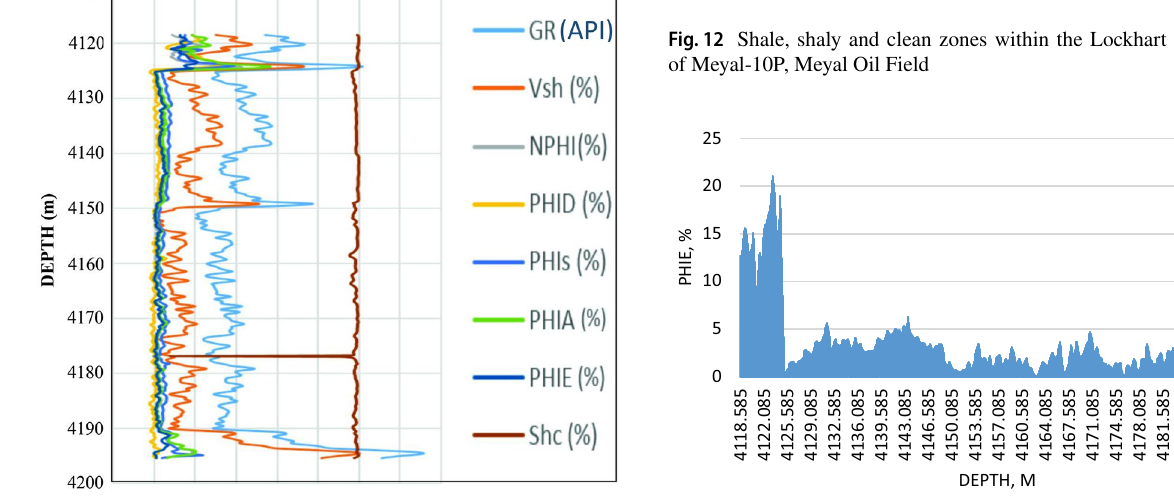
Fig. 11 Petrophysical logs of the Lockhart Limestone of Meyal-10P well, Meyal Oil Field